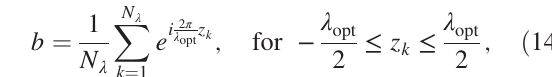
FIG. 16. Longitudinal density modulation at s ¼ 3 m in the CeC modulator induced by the moving ion with v 0 ;z ¼ σ v horizontally shifted off-axis